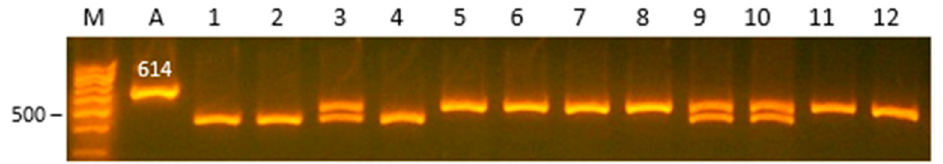
Figure 1. The Taq I polymorphism g.234500 A > T in gene FSHR : 1, 2, 4—genotype AA (446, 97, 71 bp);3, 9, 10—genotype AT (517, 446, 97, 71 bp); 5–8, 11, 12—genotype TT (517, 97 bp); A—amplicon; M—marker.